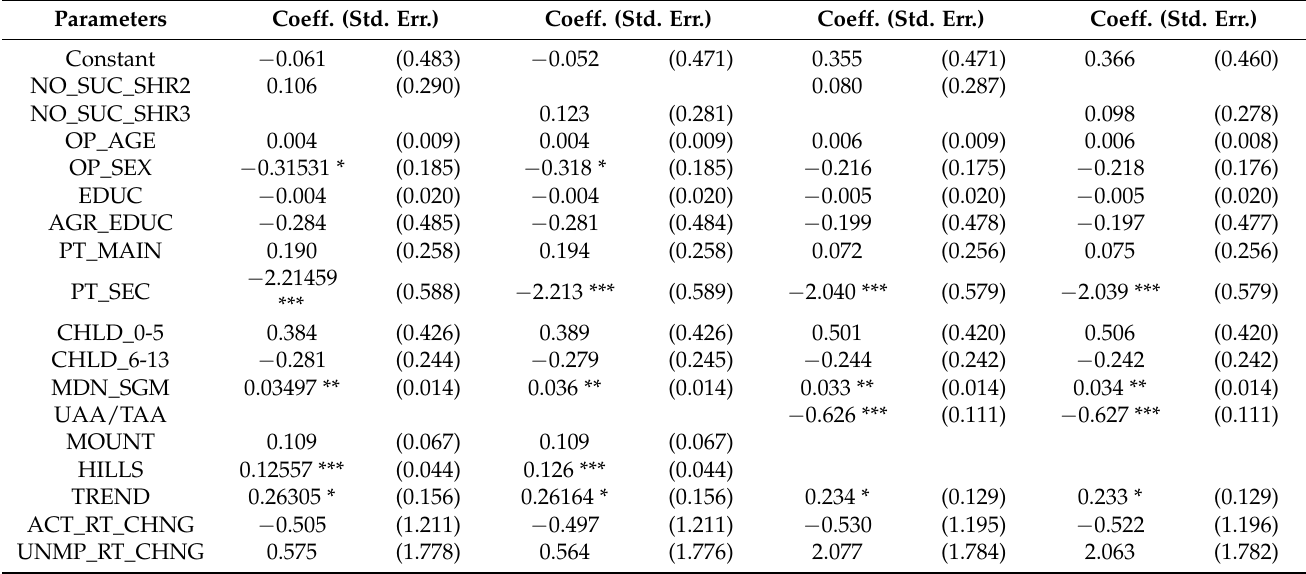
Table A7. Parameter estimates of different TAA decrease rate models using the family farms database. Parameters Coeff. (Std. Err.) Coeff. (Std. Err.) Coeff. (Std. Err.) Coeff. (Std. Err.)